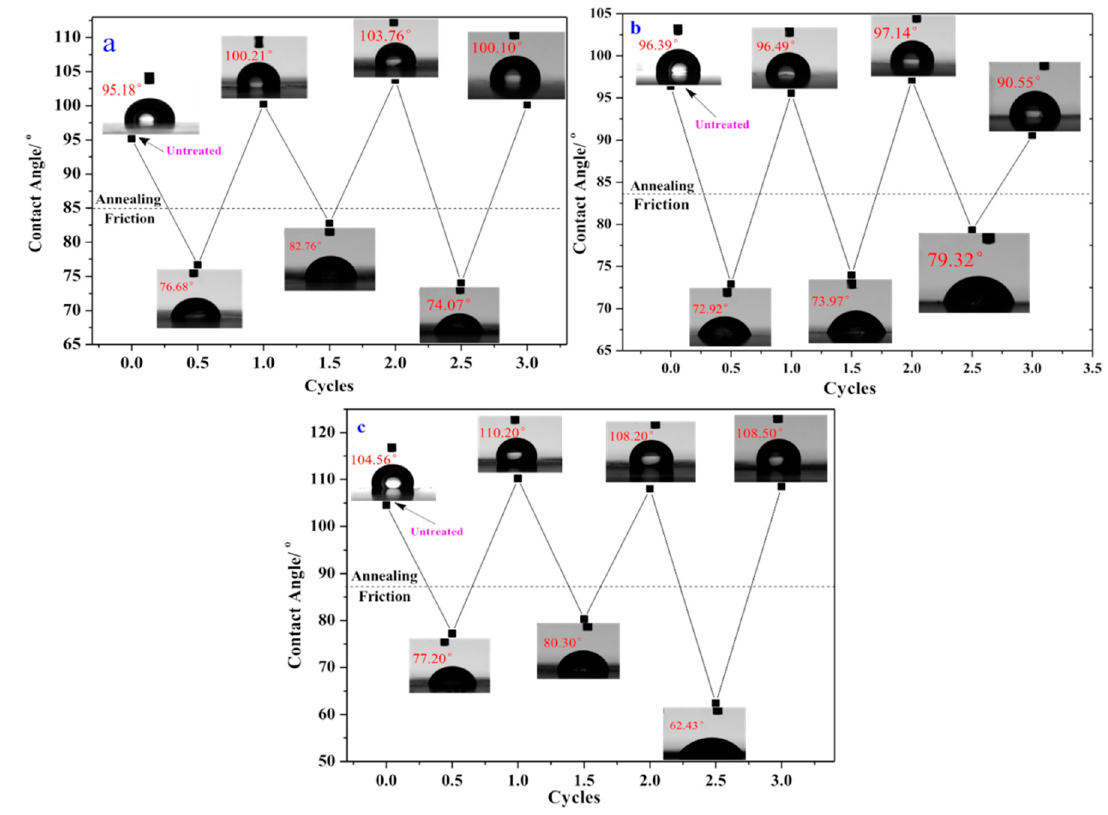
Figure 10. The friction recovering cycle test of the SG01-05 resin ( a ); The friction recovering cycle test of SG05-05 resin ( b ); The friction recovering cycle test of SG06B-05 resin ( c ).